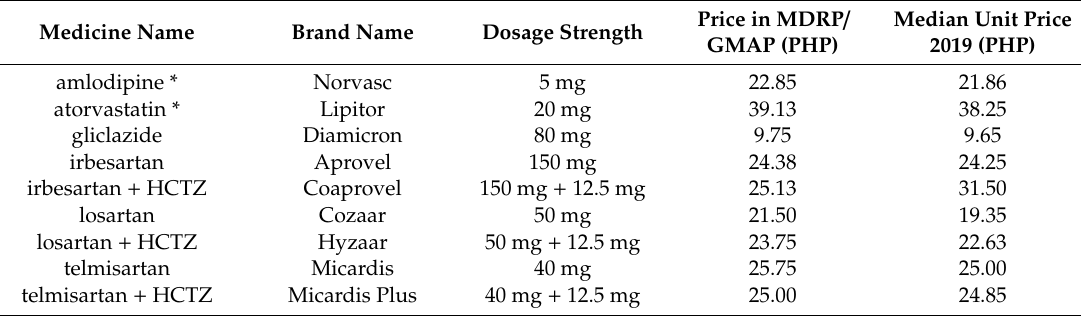
Table A3. Comparison of prices in MDRP / GMAP to the current MUP.